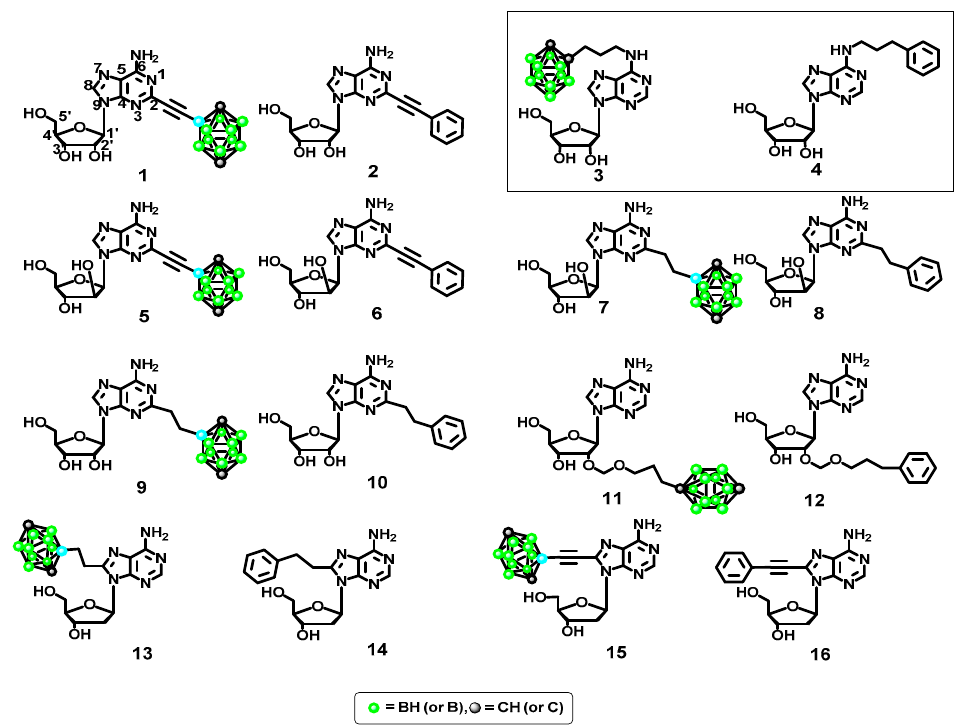
Figure 3. Modified adenosine derivatives designed as potential ligands for the A2A and A3 adenosine receptors screened in silico (dodecahedral structures correspond to the 1,12-dicarba- closo - dodecaboran-1-yl substituent, C 2 B 10 H 11